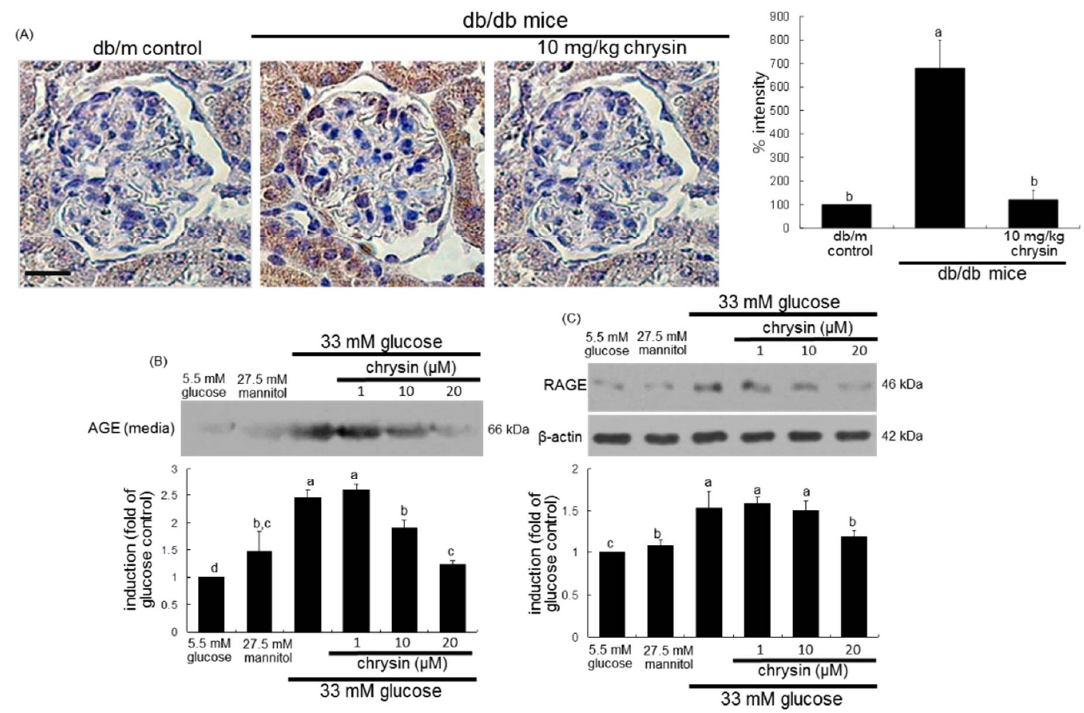
Figure 4. Effect of chrysin on AGE induction in diabetic glomeruli ( A ) and cellular production of AGE ( B ) and cellular induction RAGE ( C ) in glucose-exposed HRMC. Diabetic mice were orally administrated with 10 mg/kg chrysin for 8 weeks. For the AGE visualization, immunohistochemical staining for glomerular induction of AGE was conducted ( A ). Kidney tissue sections were immunostained with 3,3′-diaminobenzidine and nuclear counter-staining was done with hematoxylin. Each photograph is representative of four animals. Scale bar = 25 μm. The relative staining intensity was measured and the respective values are expressed as mean ± SEM. Human renal mesangial cells were challenged for 3 days with 5.5 mM glucose, 5.5 mM glucose plus 27.5 mM mannitol as osmotic controls or with 33 mM glucose in the absence and presence of 1–20 μM chrysin. The AGE production and RAGE induction was measured by using Western blot analyses of media or cell lysates with a primary antibody of AGE or RAGE ( B , C ). β-actin protein was used as an internal control. Representative blots shown are typical of three independent experiments. The bar graphs in the bottom panel represent densitometric results obtained from Image analysis. Values in bar graphs (mean ± SEM, n = 3 independent experiments) not sharing a same lower case indicate significant different at p < 0.05.